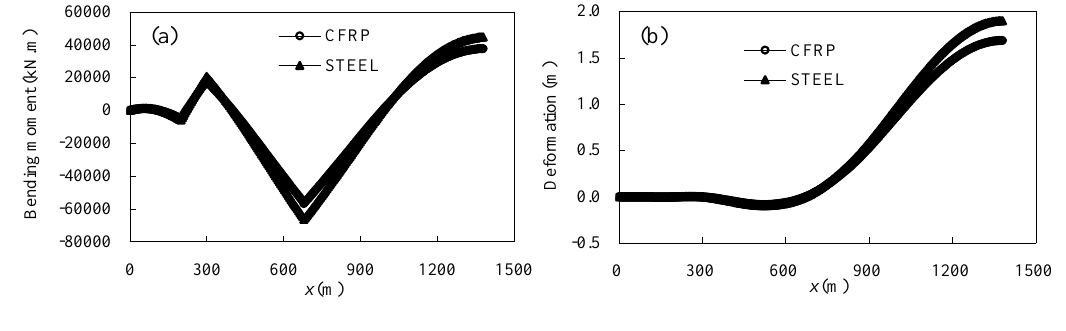
Figure 19. ( a ) Transverse bending moment of girder under wind load; ( b ) transverse deformation of girder under wind